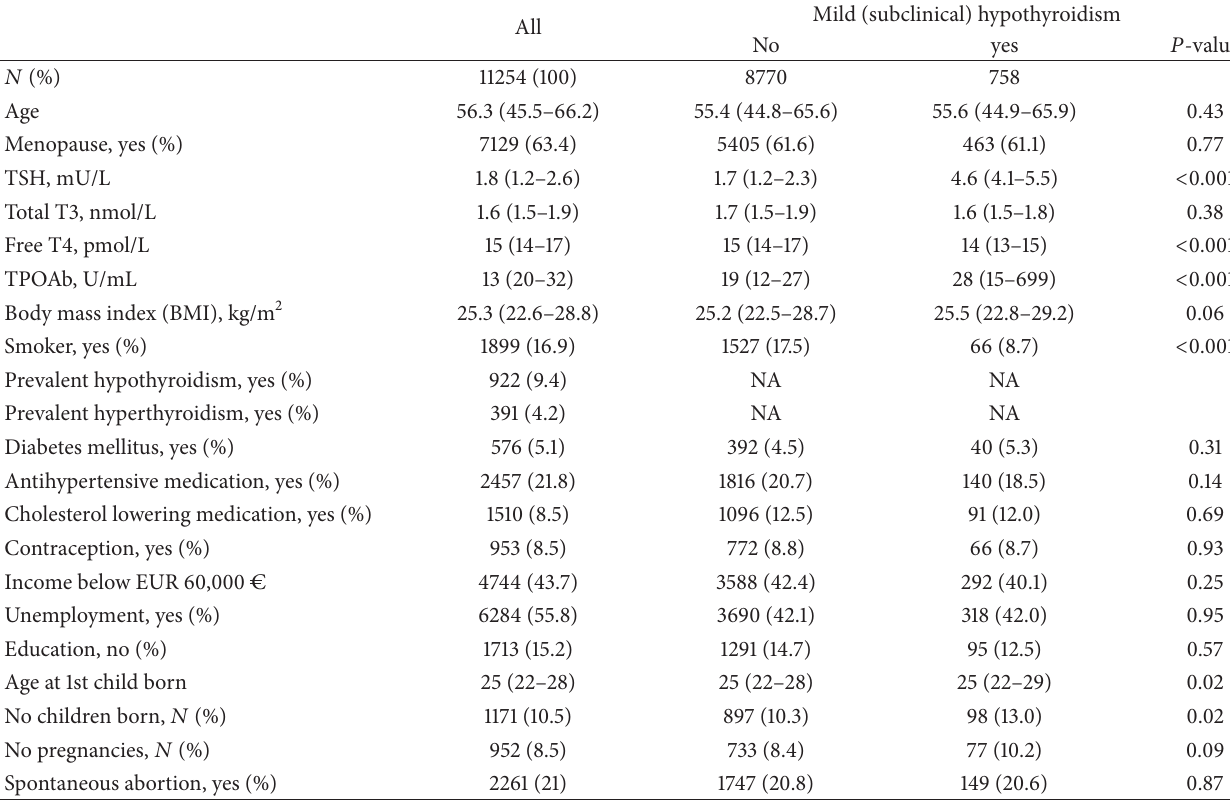
Table 1: Characteristics of women in The Danish General Suburban Population Study